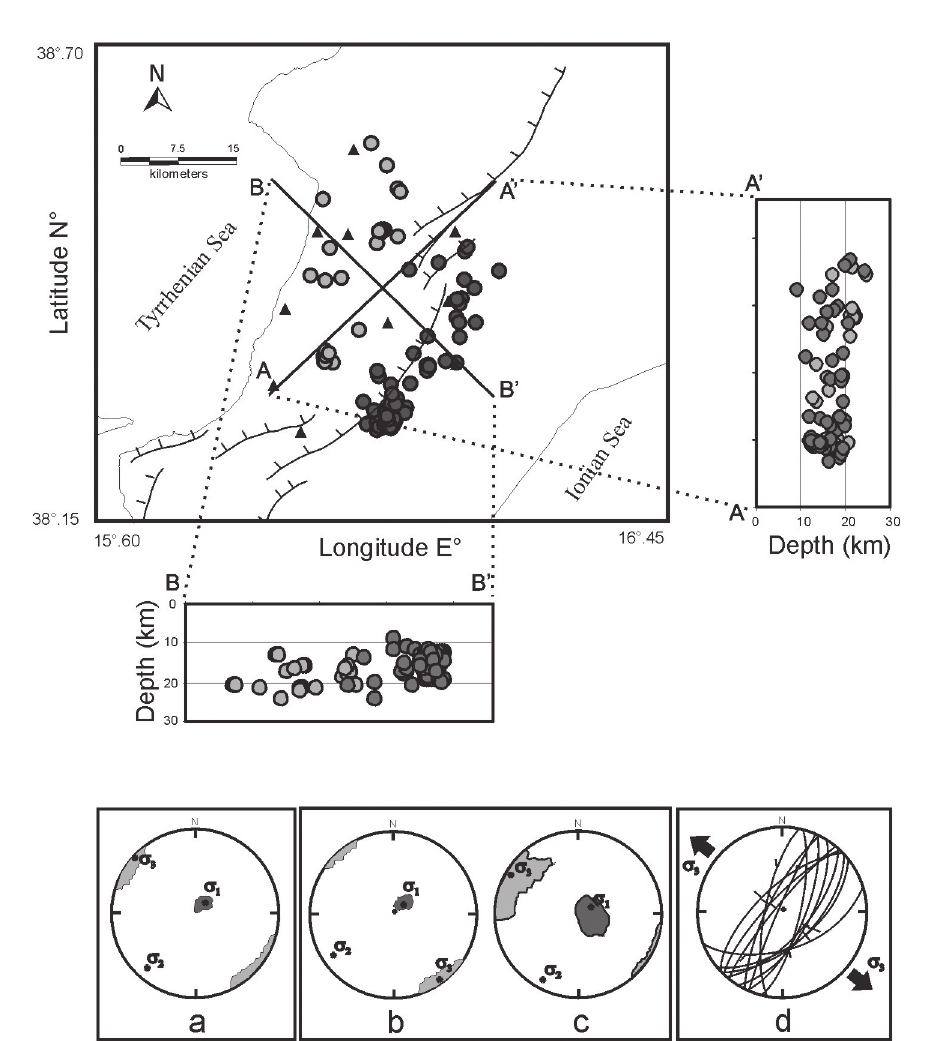
Fig. 3a-d. Map and SW-NE (A-A’) and NW-SE (B-B’) cross sections of the earthquakes selected for stress tensor inversion. Lower-hemisphere projection of the orientations (stars) of the principal stress axes obtained by inverting the whole dataset (a) and the two different subsets (b) and (c). Gray areas indicate the 90% confidence limits of σ 1 and σ 3 orientations. d) Diagram (Schmidt net, lower hemisphere) showing fault planes and slicken- sides measured along cataclastic belts of Cittanova fault. Large arrows indicate azimuth of the mean extension direction derived from a qualitative and quantitative analysis of the slickenside data sets (Tortorici et al. ,